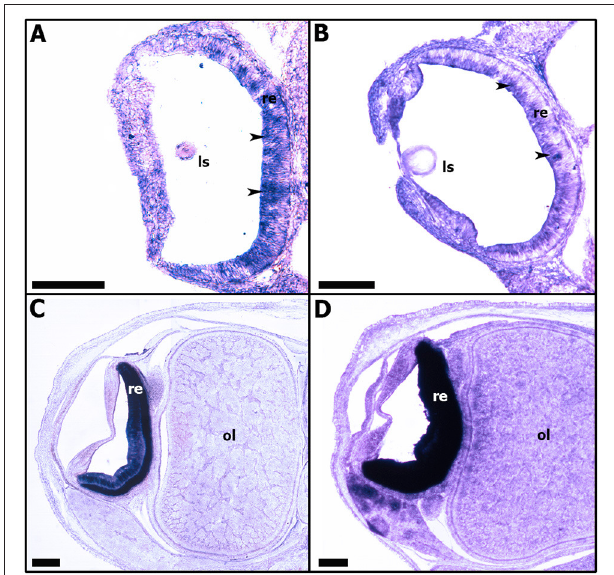
FIGURE 9 | Expressions of Sof-rhodopsin during S. officinalis organogenesis on transversal cryo-sections. Dorsal side is up and ventral side is down. (A,B) : expressions in the developing retina (black head arrows) respectively at stages 23 and 25. (C,D) : expressions in differentiating retina, respectively at stages 28 and 30. ls: lens; ol: optic lobe; re: retina. Scale bar is 200 µ